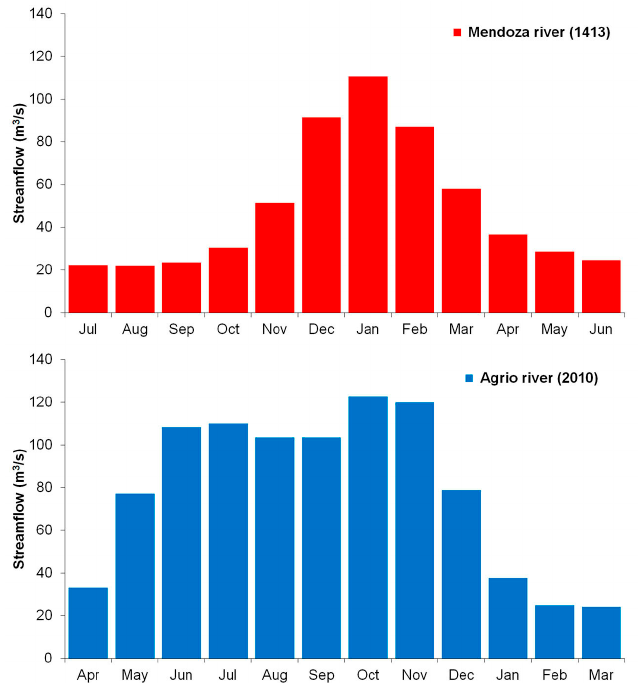
Figure 2. Hydrological cycles from two regional representative basins: the Mendoza River for the Central Andes of Argentina (CAA) and the Agrio River for North Patagonia (NP).